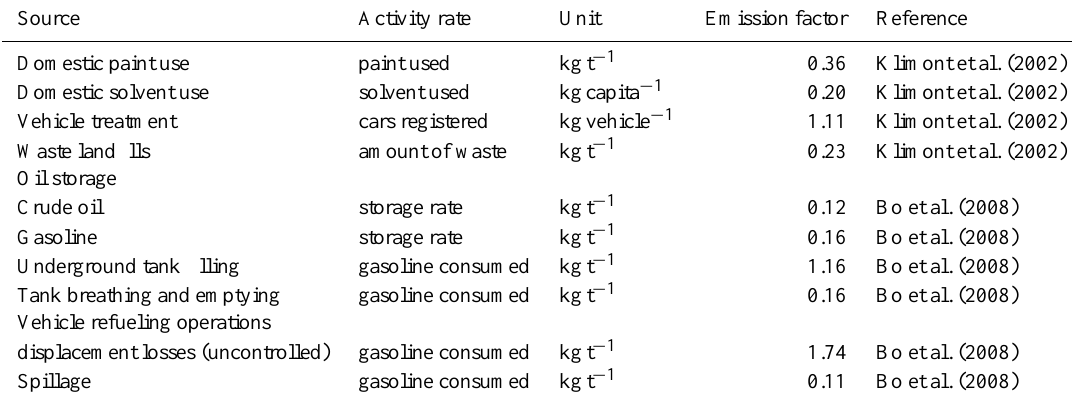
Table 4. Emission factors of fugitive VOCs emission sources.